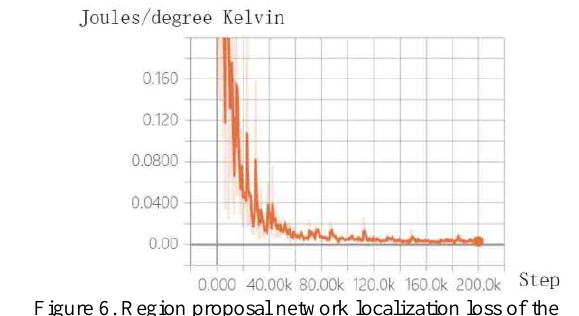
Figure 6. Region proposal network localization loss of the extraction result